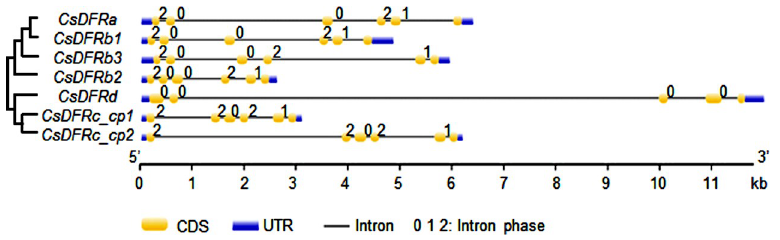
Fig 1. Gene structures of putative CsDFRs with phylogenetic relationship of their mRNAs. CsDFRa and CsDFRbs have the same exon amounts and intron phases. Data for this figure could be found in S2